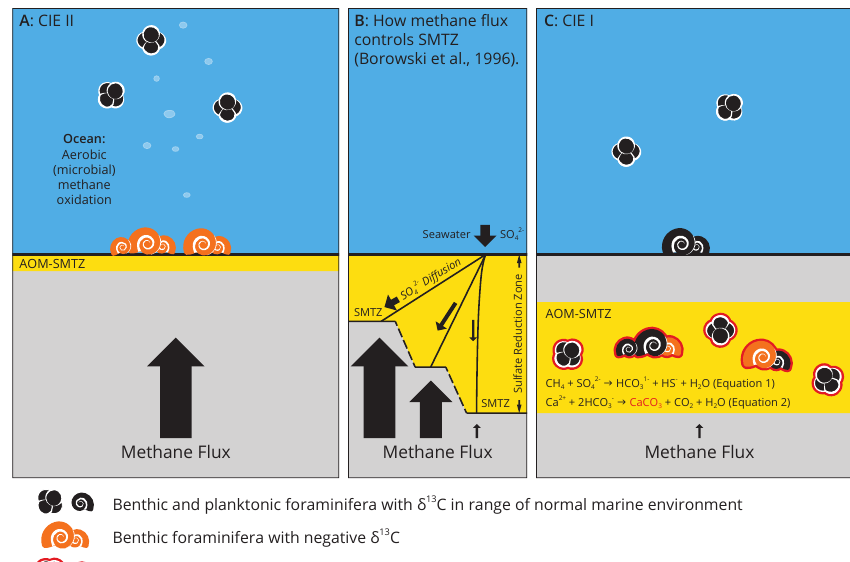
Figure 9. (a) Schematic diagram representing CIE II, where only benthonic foraminifera exhibit negative δ 13 C values. In this scenario, methane activity is sufficiently high as to surpass the SMTZ and oxidized less efficiently with the consequence of lower AOM rates and higher methane fluxes into the bottom waters. The methane escaped is then partially oxidized by methanotrophic aerobic microbes in the water column. In this scenario the negative δ 13 C values are likely to be the result of calcification in the presence of 13 C-depleted DIC and probably ingestion of 13 C-depleted methanotrophic microbes on which foraminifera feed. (b) Schematic diagram showing how methane flux controls the SMTZ if the flux of sulfate (SO 2 − ) from the seawater and the characteristics of the sediments are constant. Arrow size is 4 proportional to upward methane flux. Modified after Borowski et al. (1996). (c) Schematic diagram representing CIE I, where both benthonic and planktonic foraminifera exhibit negative δ 13 C values. In this case the methane flux is low and upward fluxes of methane and downward fluxes of sulfate (coming from the sea water) meet within the SMTZ and the anaerobic oxidation of methane (AOM) can take place (e.g. Boetius et al., 2000; Knittel and Boetius, 2009). Here, sulfate and methane may be consumed simultaneously according to Eq. (1). The production of bicarbonate from AOM can induce the precipitation of calcium carbonate, so-called methane-derived authigenic carbonates, on the benthonic and planktonic foraminifera tests after burial through Eq.